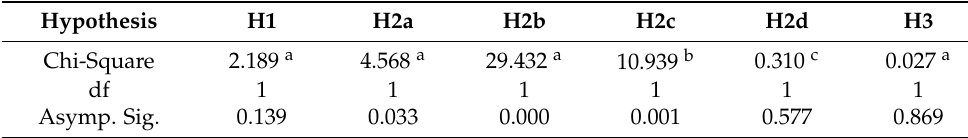
Table 4. Hypothesis test